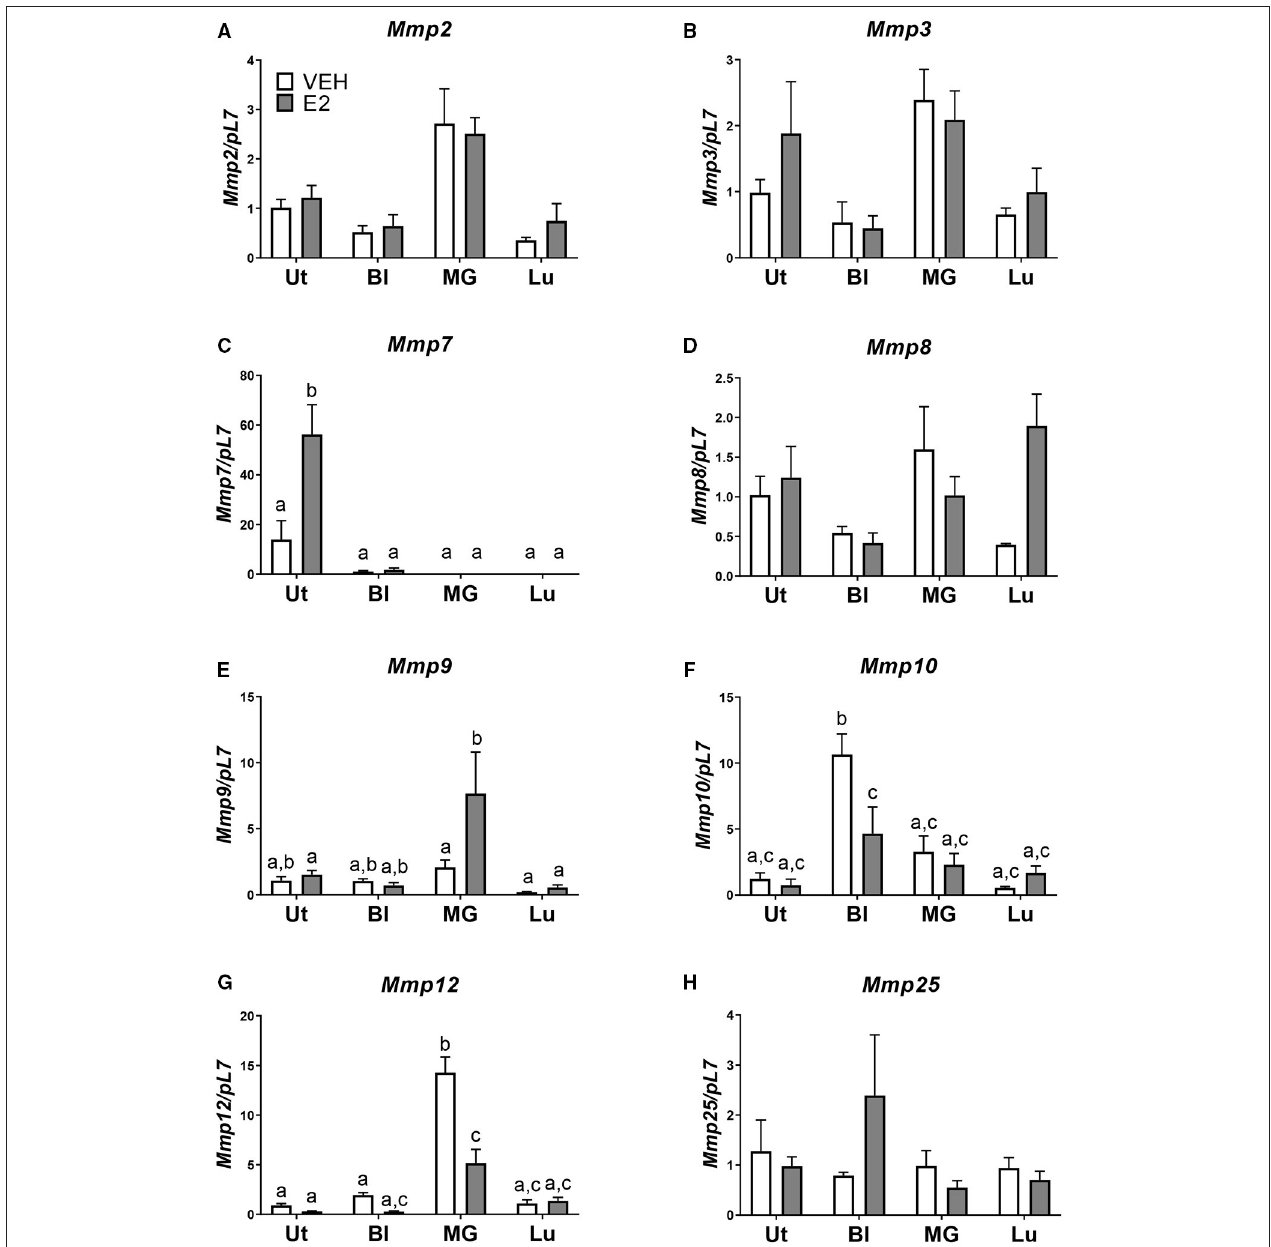
FIGURE 3 | Mmp7 is highly expressed in endometriotic lesions and enhanced with E 2 . (A–H) Gene expression of MMP family members in lesions/removed tissues. (A) Mmp2 , (B) Mmp3 , (C) Mmp7 , (D) Mmp8 , (E) Mmp9 , (F) Mmp10 , (G) Mmp12 , and (H) Mmp25 . Samples are normalized to uterus vehicle (set to 1) except for Mmp7 in which bladder vehicle is set to 1. Tissue was removed, RNA was isolated, and gene expression was determined by RT-PCR. Letters different than each other are statistically significant, p < 0.05, two-way ANOVA, Tukey’s